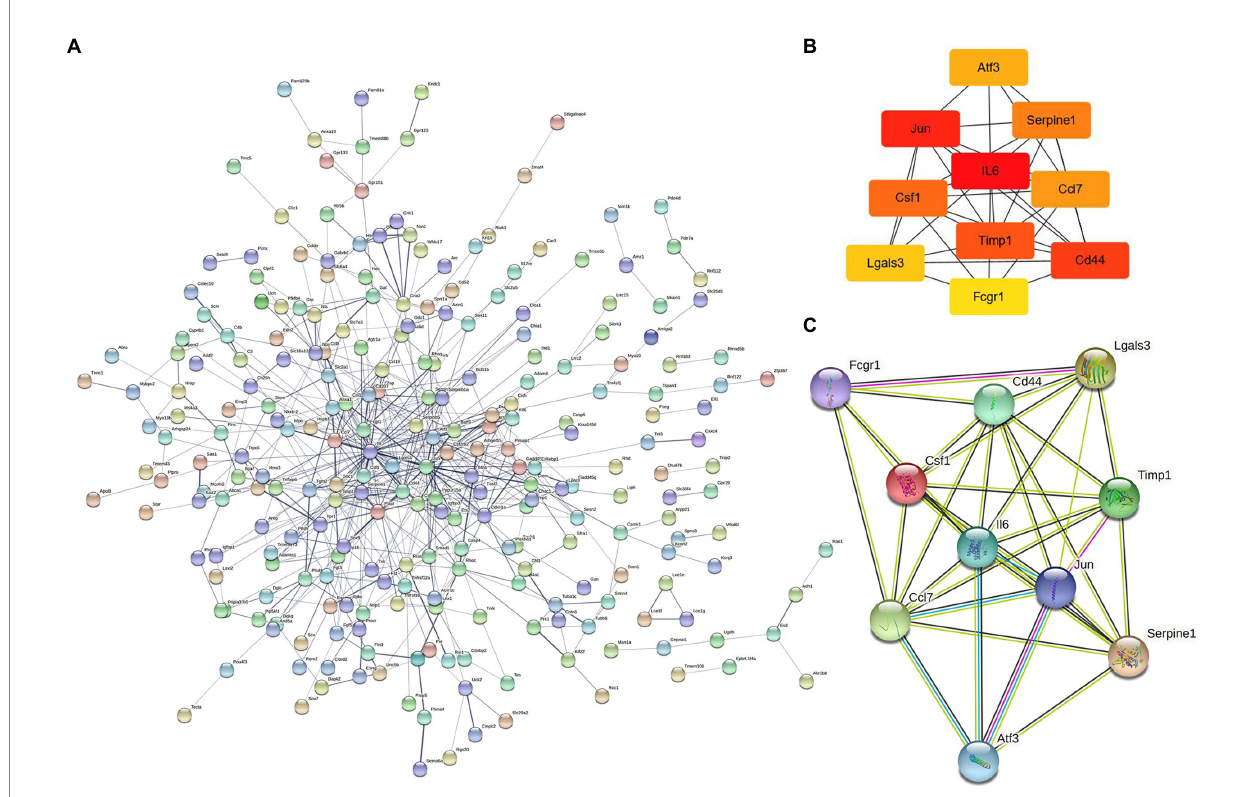
FIGURE 3 The construction of protein–protein interaction network and identification of hub genes. (A) PPI network is established by 421 DEmRNA-encoded proteins using the STRING website. (B) Relationship network diagram of hub genes from PPI network using cytoscape. (C) Relationship network of 10 hub genes that extracted from the PPI network and the structure of proteins they